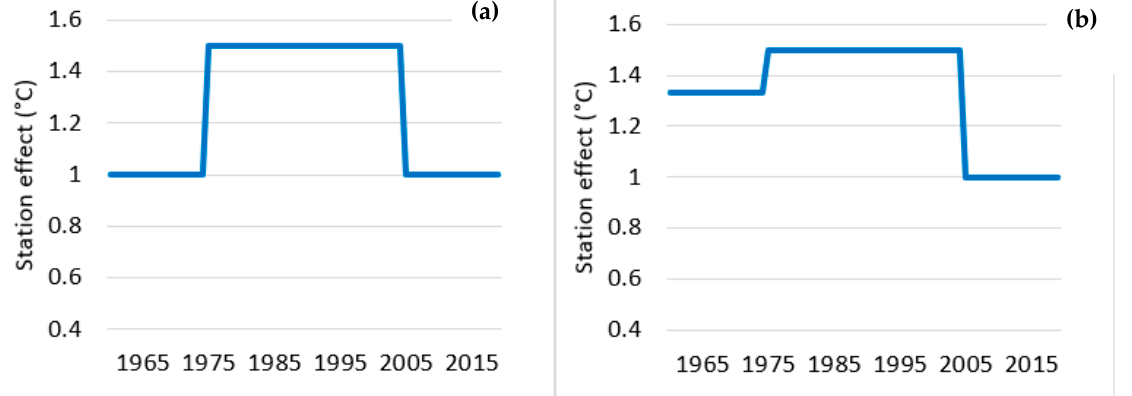
Figure 9. Two breaks of a platform shaped inhomogeneity in a synthetic example of the variation of station effect. Left panel ( a ) before homogenization; right panel ( b ) after the adjustments for the first break when the second break has remained undiscovered.